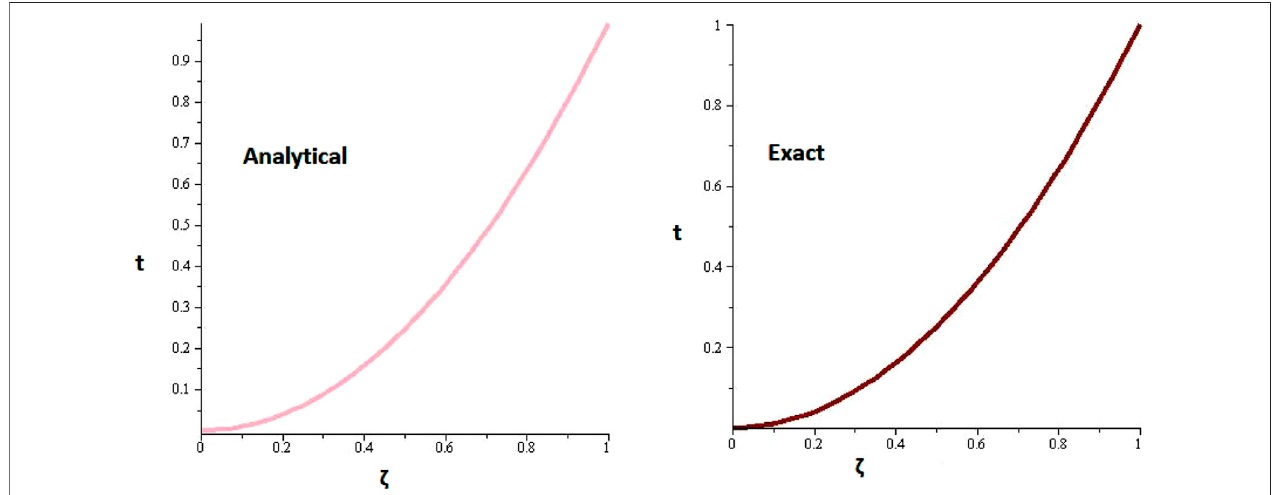
FIGURE 2 | 2D plots for the exact and analytical solution at γ =1 for Example 1.